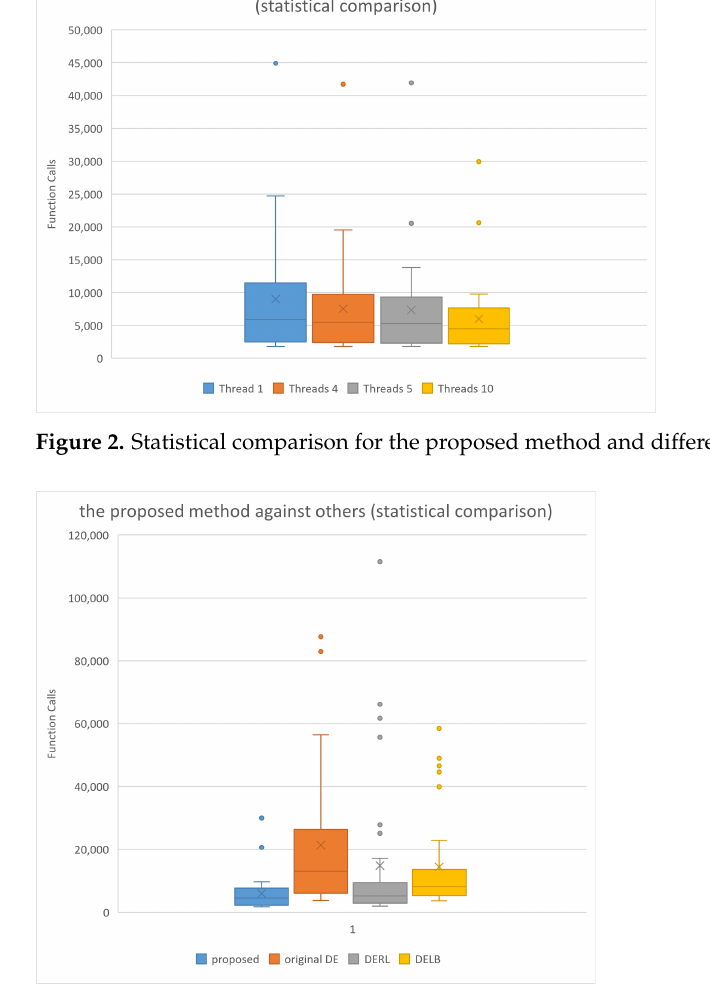
Figure 3. Statistical comparison for the results of the proposed method against different variations of the DE